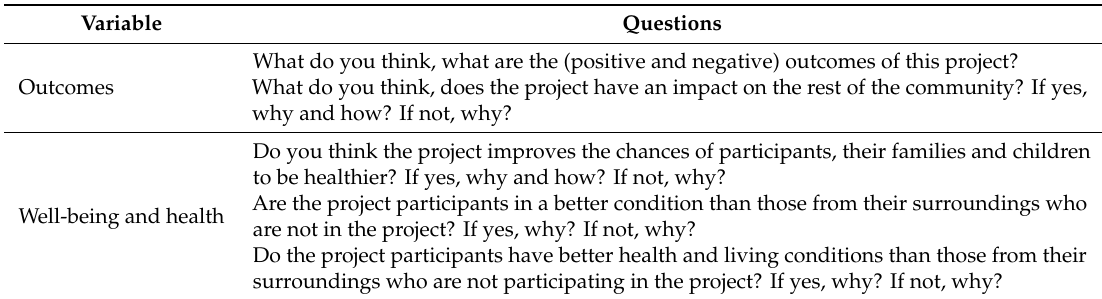
Table 2. Variables and questions in the data collection based on the CMO framework, in particular regarding well-being and health as an